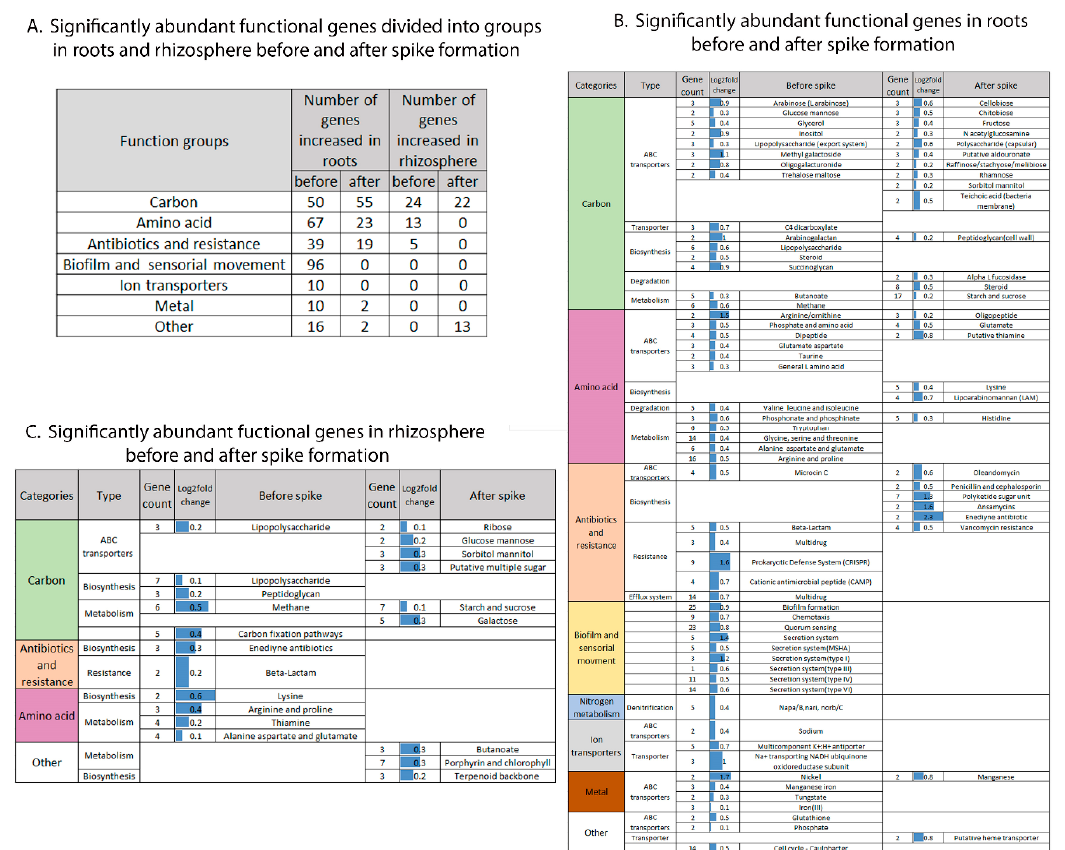
Figure 6. Temporal effect on microbiome functions. Significantly abundant functional genes before and after spike formation, divided into groups ( A ) and in roots ( B ) and rhizosphere ( C ).